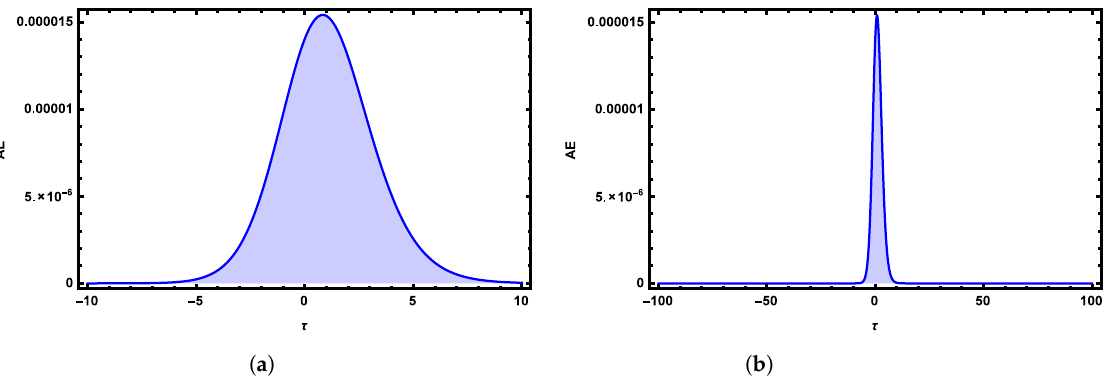
Figure 4. Absolute Error (AE) 2D graph of obtained numerical solutions using FNAM verses